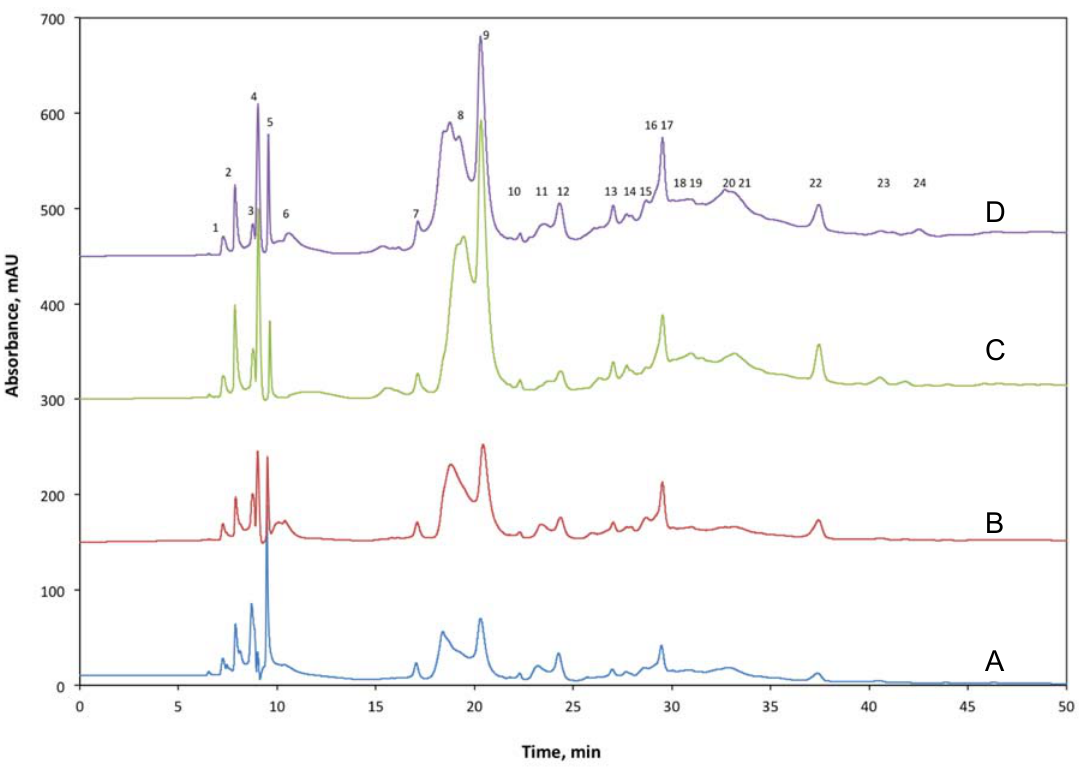
Figure 3. Chromatograms obtained by HPLC-DAD at 280 nm after analysis of extracts prepared with solid–liquid (S-L) procedure, without microwave irradiation ( A ) and after SFI ( B ), SAI ( C ) and PSAI ( D ) pretreatments followed by S-L procedure. For identification purposes see Table 2. Table 2. Putative identification of compounds presented in the chromatograms and their corresponding retention time (Rt) and maximum absorption wavelength ( λ max ).